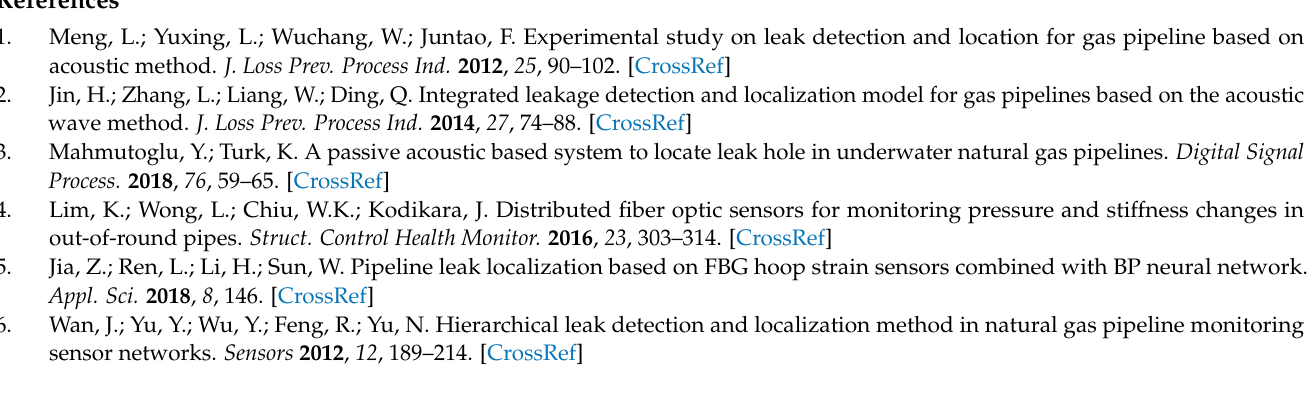
Figure 11. The effectiveness of the proposed technique for fault estimation at leakage point in pipe.